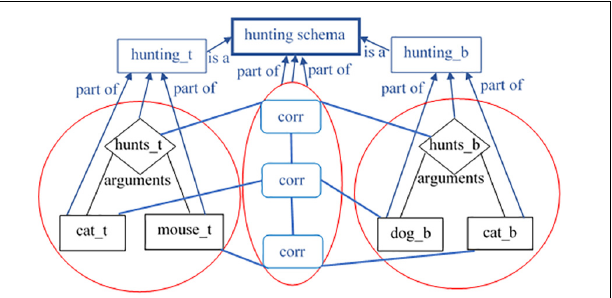
TABLE 1 | The set of situations used for testing RoleMap ’s stability.